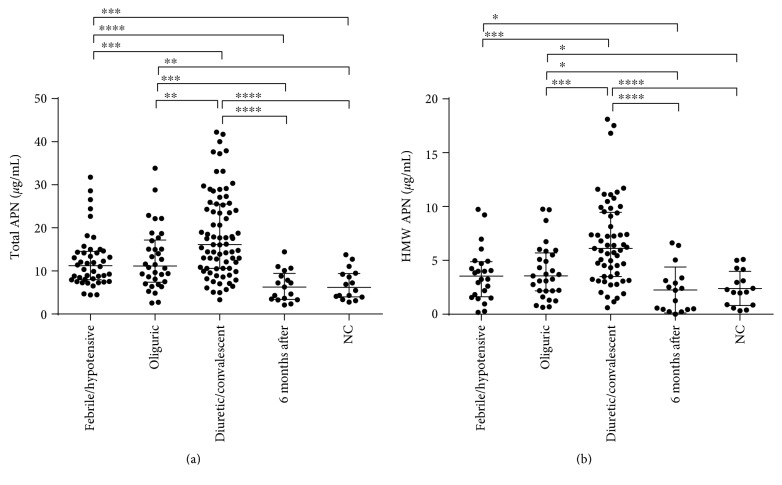
Dynamic changes of the total adiponectin (APN) and high molecular weight (HMW) APN levels in the plasma of patients with HFRS. Comparison of (a) total APN and (b) HMW APN levels in the plasma of patients with HFRS over the different stages of the disease and 6 months after discharge from the hospital. Both total APN and HMW APN levels in the plasma of patients with HFRS were generally elevated starting from the onset of fever, gradually continued to elevate during the course of the disease, and recovered to normal levels when assessed 6 months after discharge. The data were obtained from 171 plasma samples of patients with HFRS and from 16 plasma samples of healthy subjects included as normal controls (NC). The Mann–Whitney U test was used to determine the significance of the difference between two groups, and the black lines represent the medians with the corresponding interquartile range. ∗p < 0.05; ∗∗p < 0.01; ∗∗∗p < 0.001; ∗∗∗∗p < 0.0001.